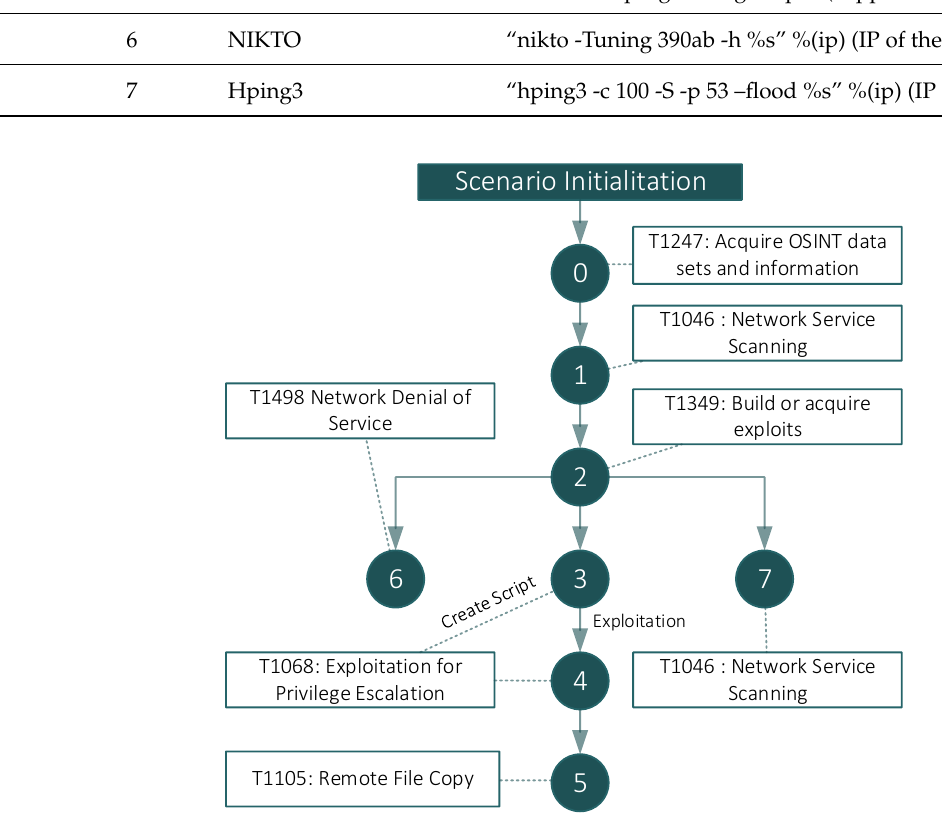
Figure 5. Scenario 1—Cyber kill chain for Data